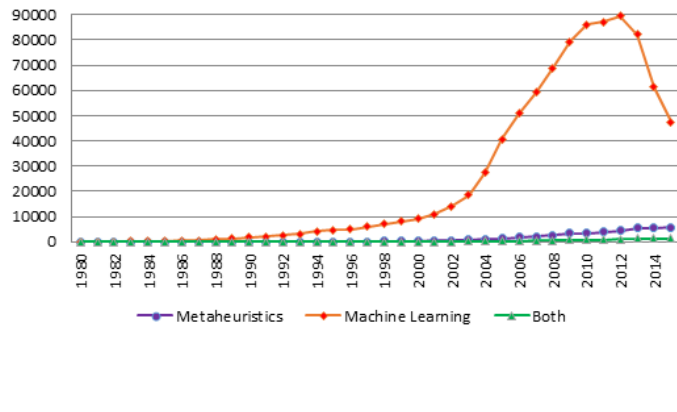
Fig. 3. Evolution of the number of works in Google Scholar (March 15, 2016). The number of works from the fields of metaheuristics and statistics or data mining were 1880 and 785 in 2015,